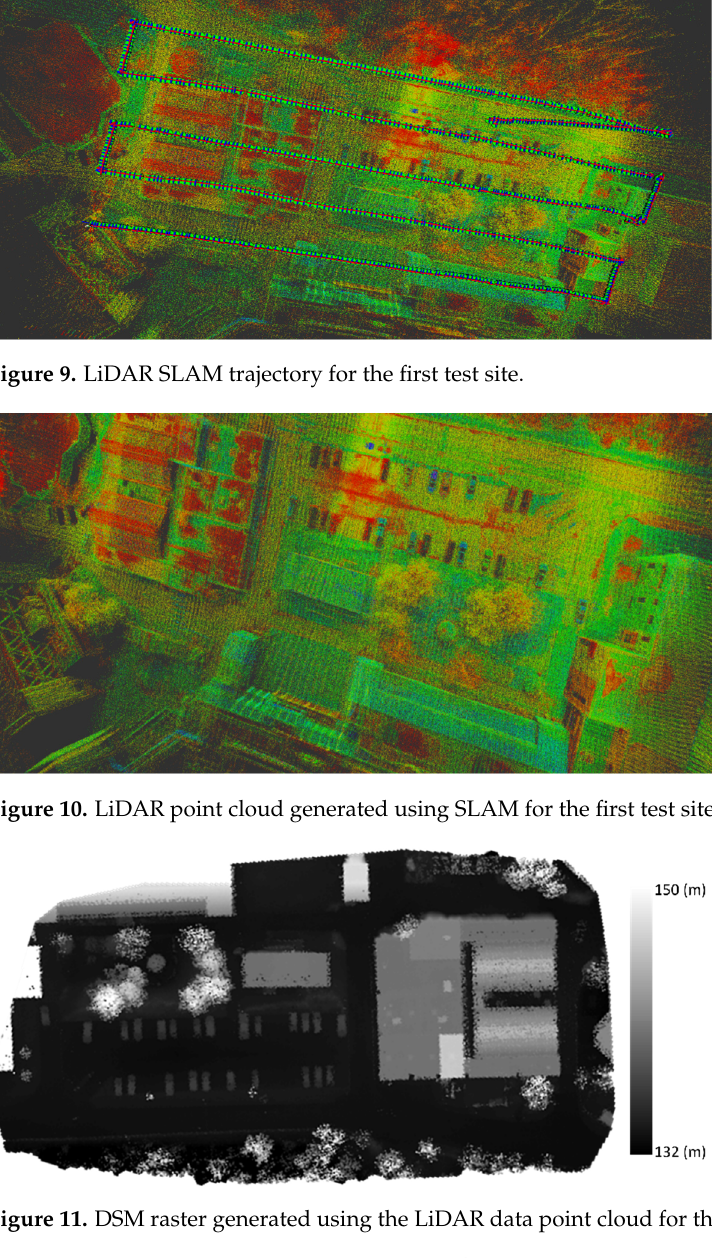
Figure 11. DSM raster generated using the LiDAR data point cloud for the first test site.